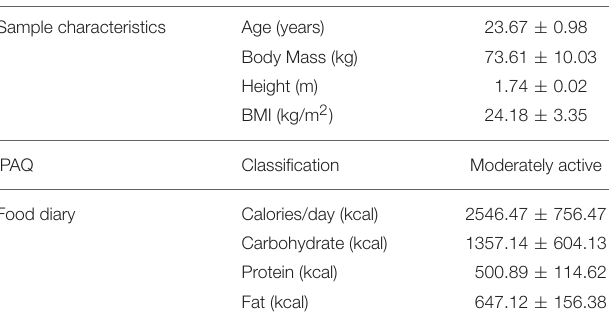
TABLE 1 | Sample characteristics, IPAQ, and food diary.